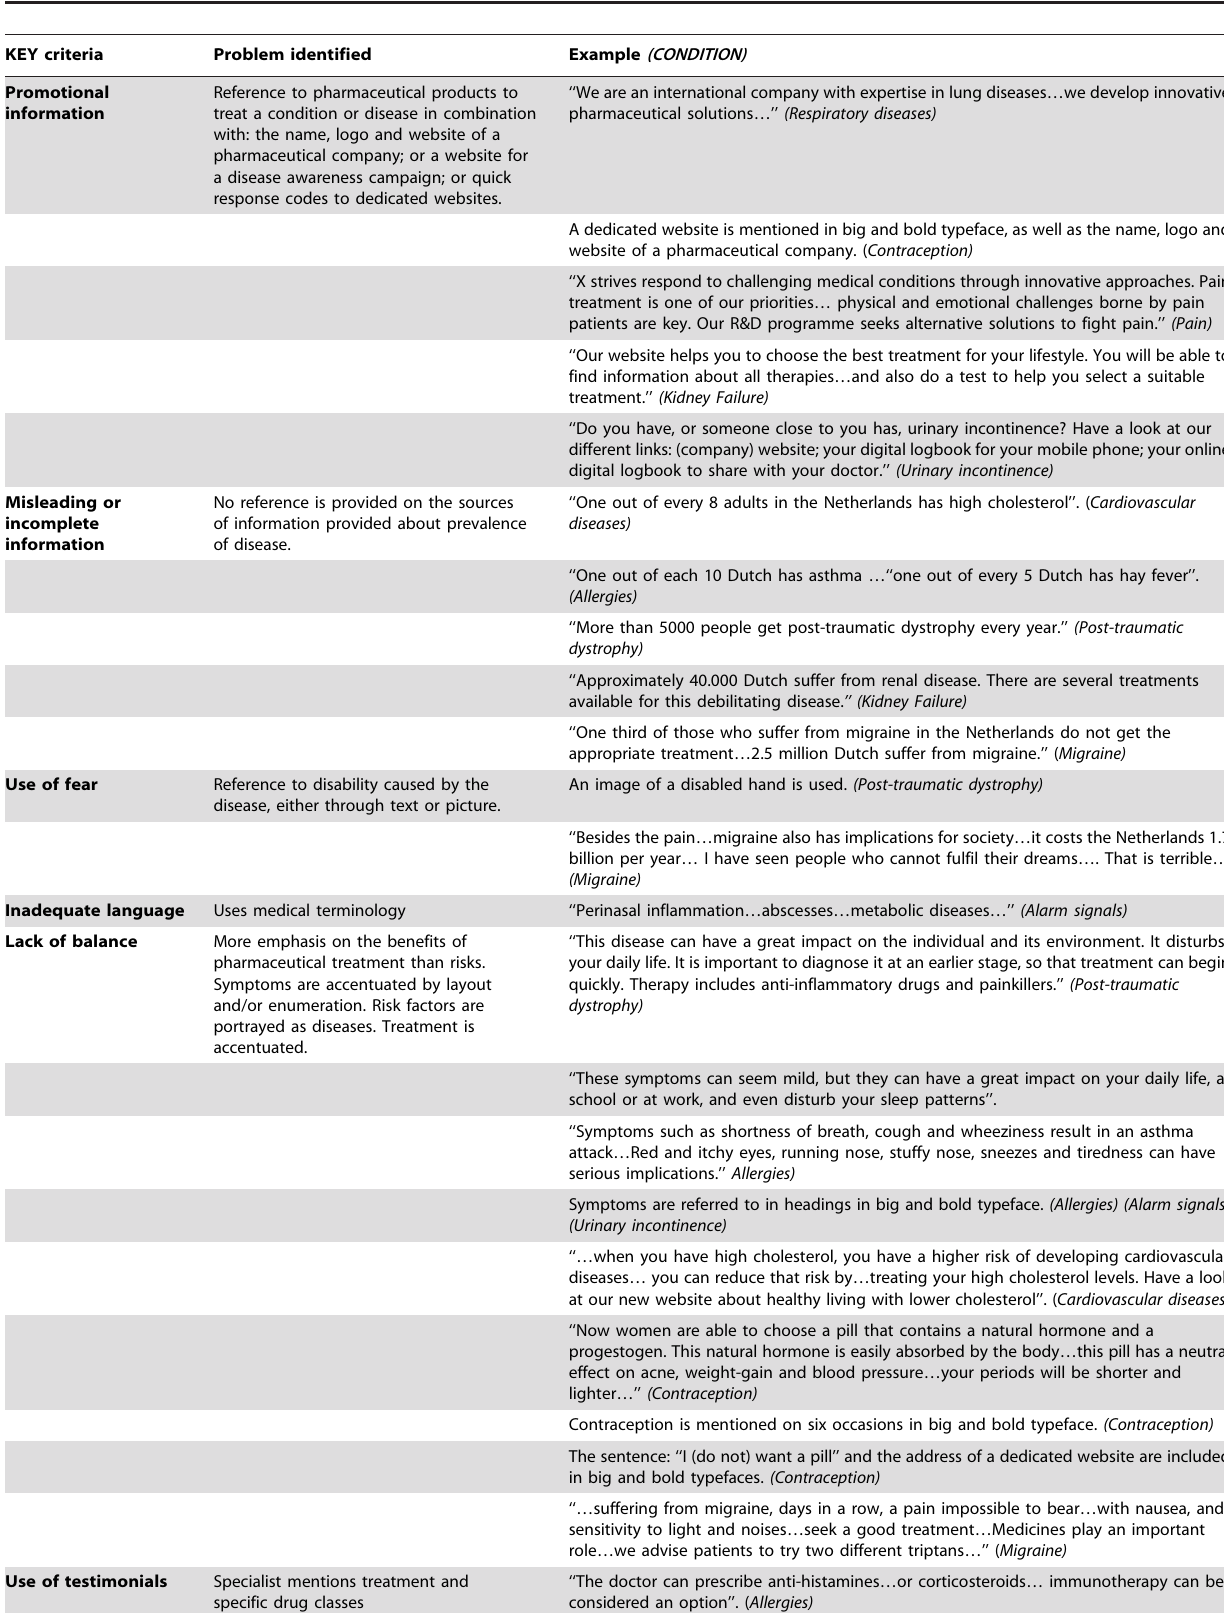
Table 3. Examples of non-compliance per key criteria from the disease awareness campaigns.